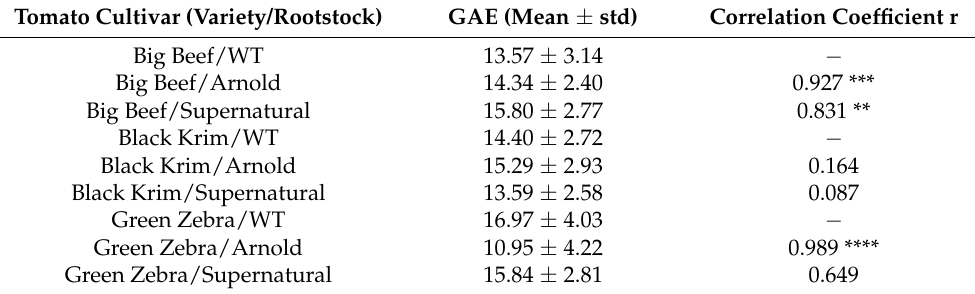
Table 5. Total phenolic content of tomato extracts as analyzed by the Folin–Ciocalteu assay. Phenolic content was calculated as gallic acid equivalents (GAE; µ mol/g tomato dry weight). Analysis using Pearson correlation showed that the antioxidant capacity was strongly correlated for Big Beef grafted onto Arnold and Supernatural and Green Zebra grafted onto Arnold, compared with the self-grafted cultivars. A correlation coefficient of r < − 0.7 or r > 0.7 was considered a strong correlation. Tomato Cultivar (Variety/Rootstock) GAE (Mean ± std) Big